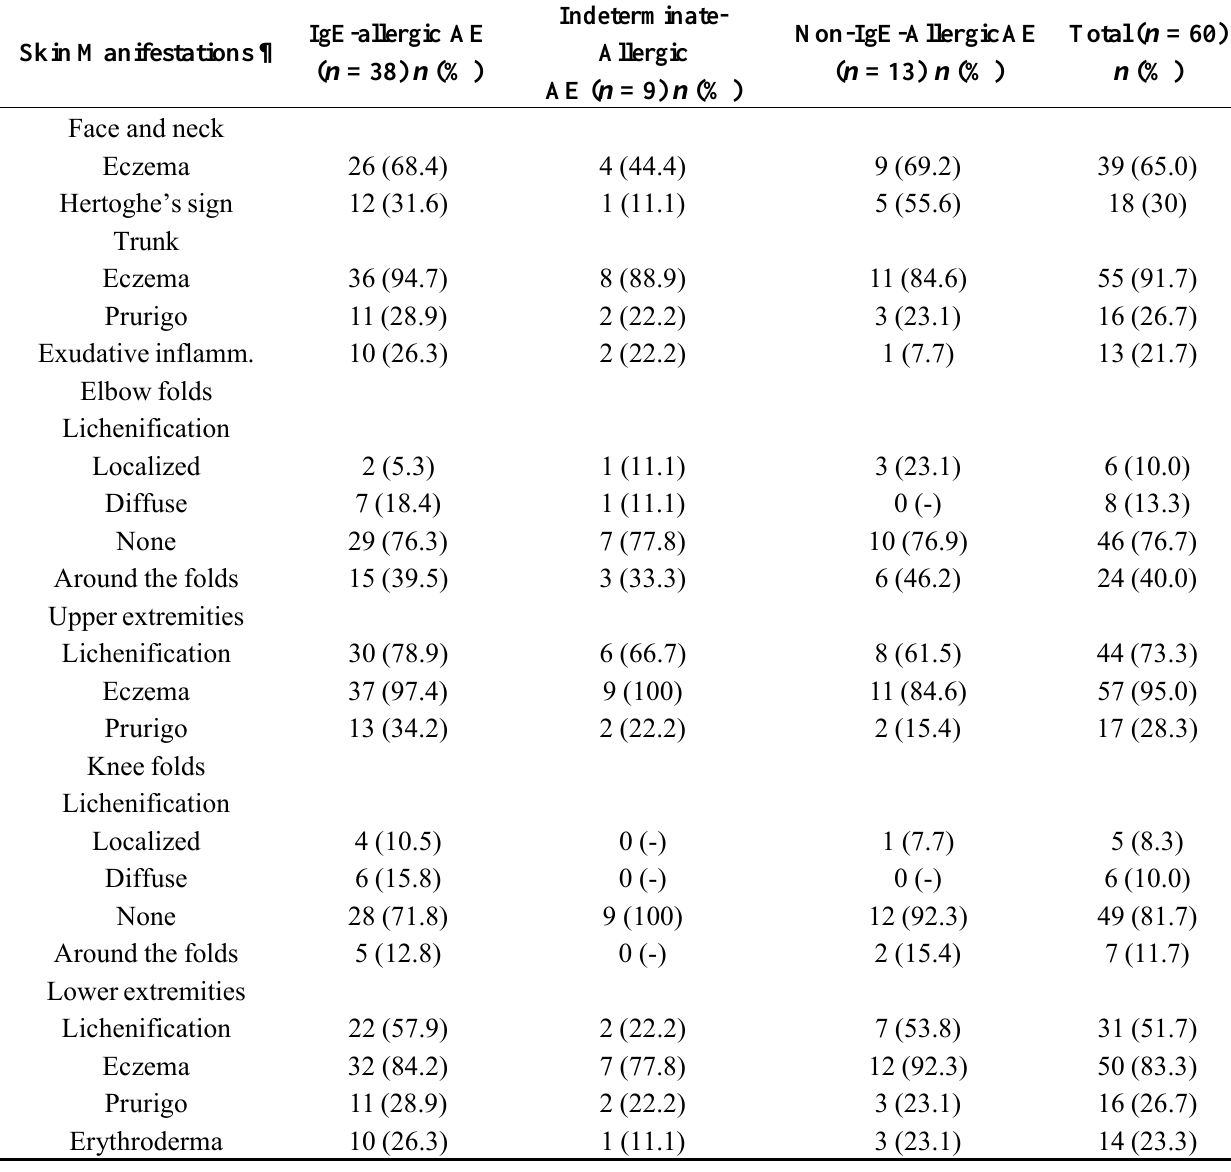
Table 3. Skin manifestations in elderly patients with atopic eczema